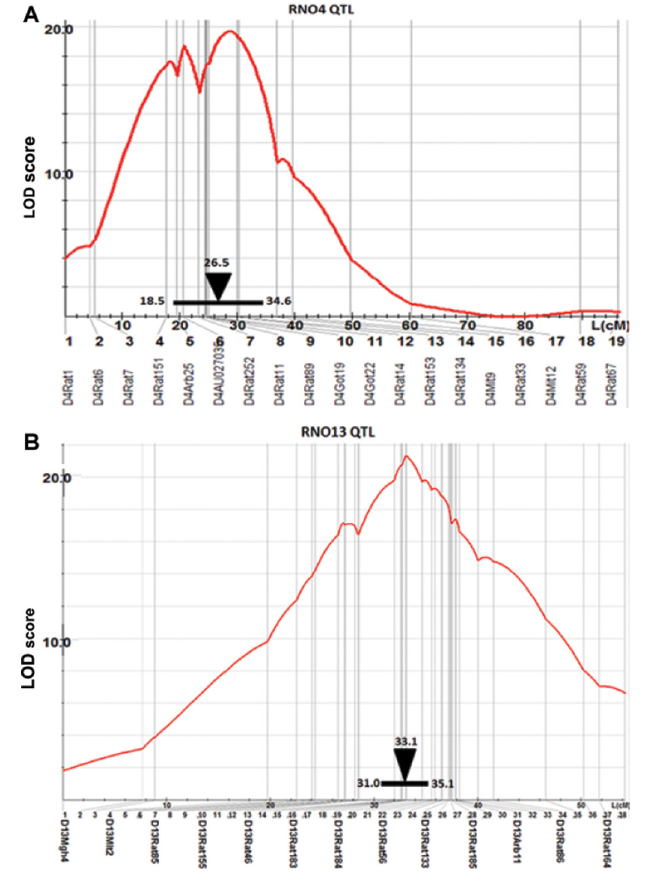
Table 2. When the genotype at all loci